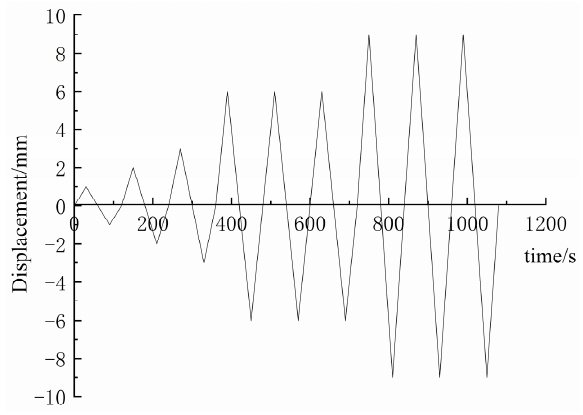
Figure 3. Loading curve